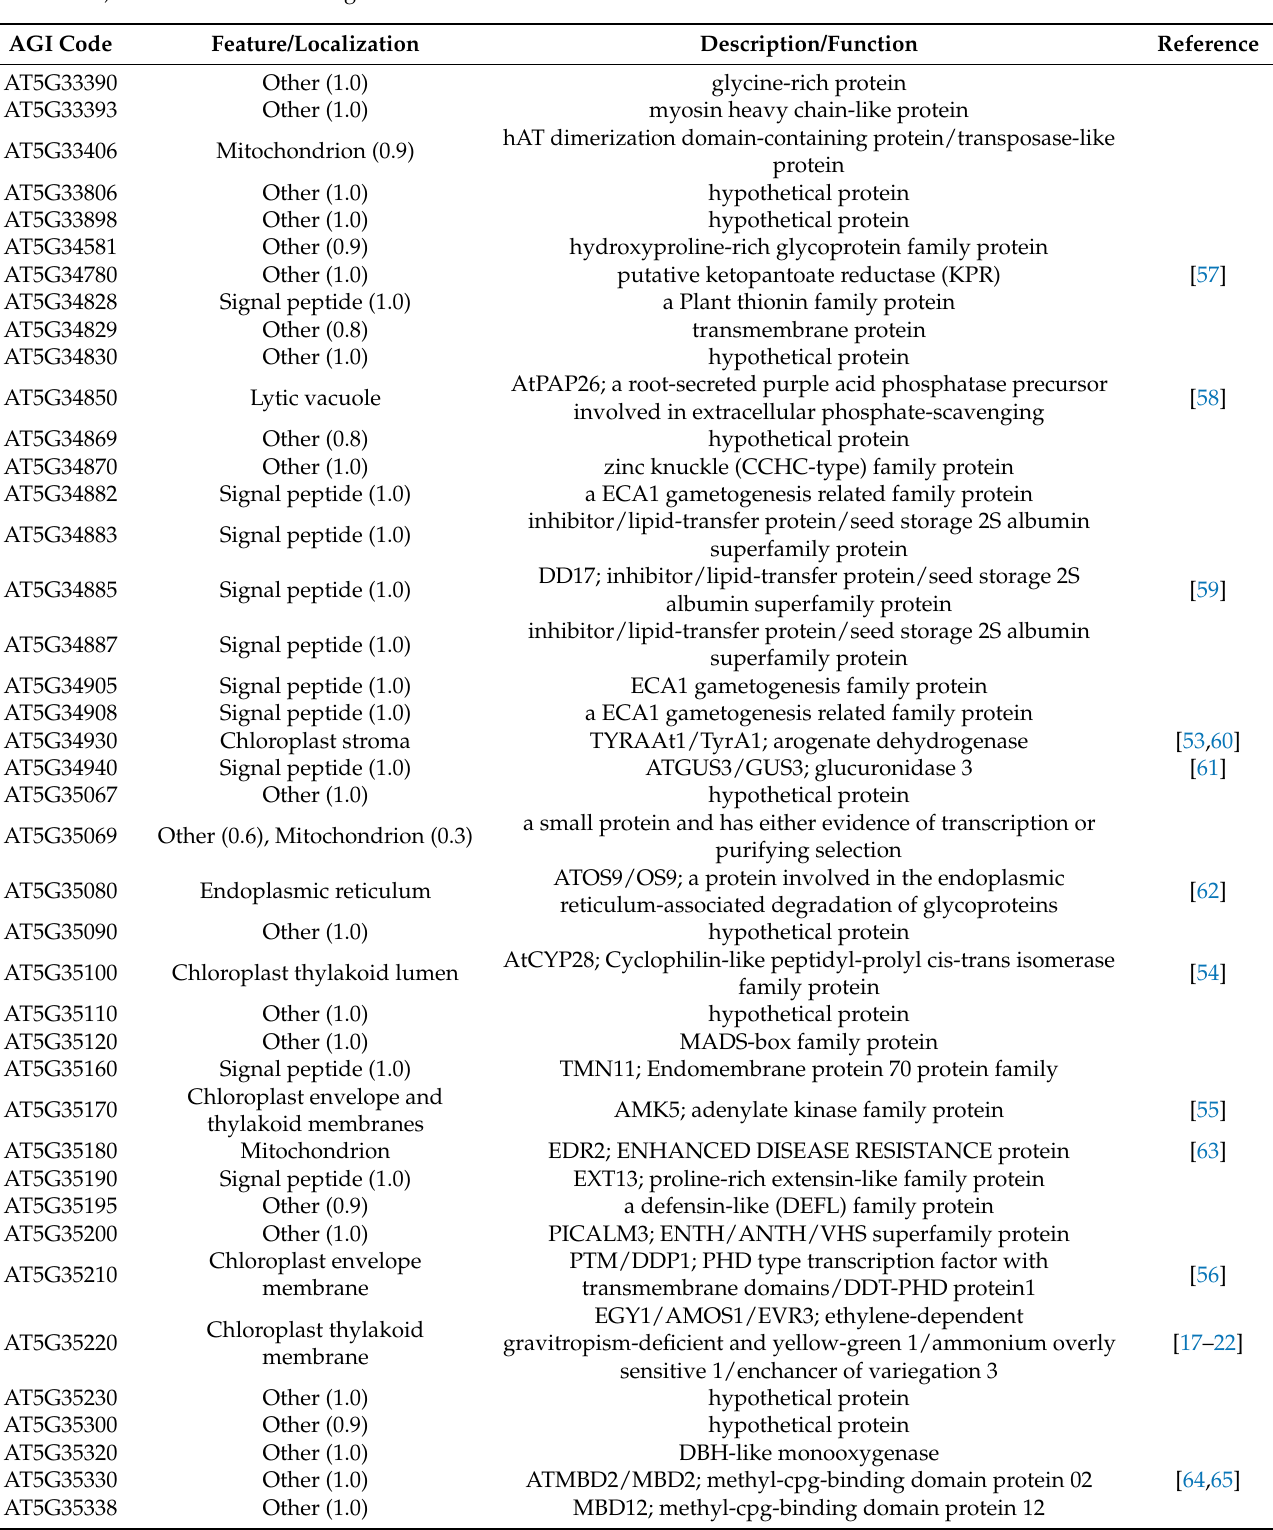
Table 2. List of protein-coding genes deleted in Ar50-33-pg1. AGI codes and gene descriptions were compiled from the TAIR site (https://www.arabidopsis.org, accessed on 21 April 2021). References are provided for characterized genes. The feature/localization column contains experimentally determined information or the localization or protein signature predicted by TargetP software (http://www.cbs.dtu.dk/services/TargetP/, accessed on 21 April 2021) (probability in bracket). Full details of deleted genes are in Table